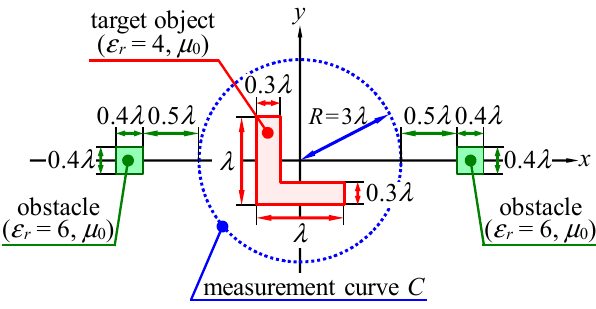
Figure 14. Geometry of inverse scattering analysis including unwanted obstacles.